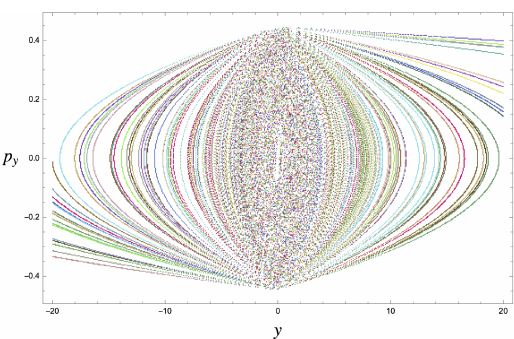
Figure 7 . Poincaré sections for E = 0 . 1 . Each color represents a different